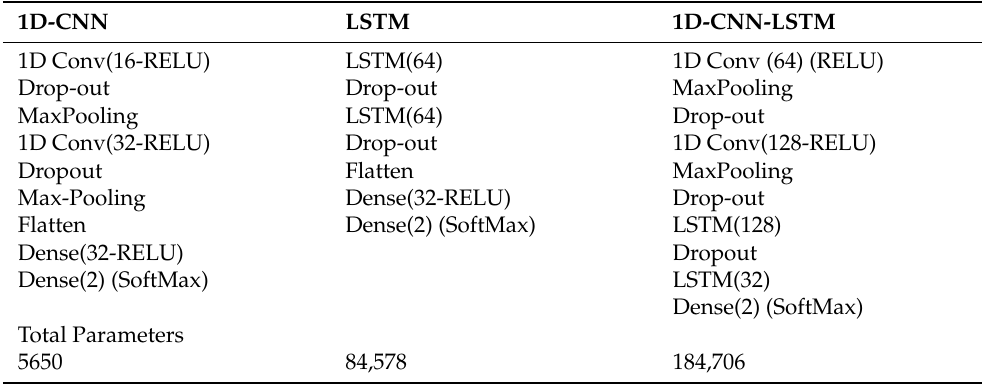
Table 3. The deep learning algorithm designs for Frequency